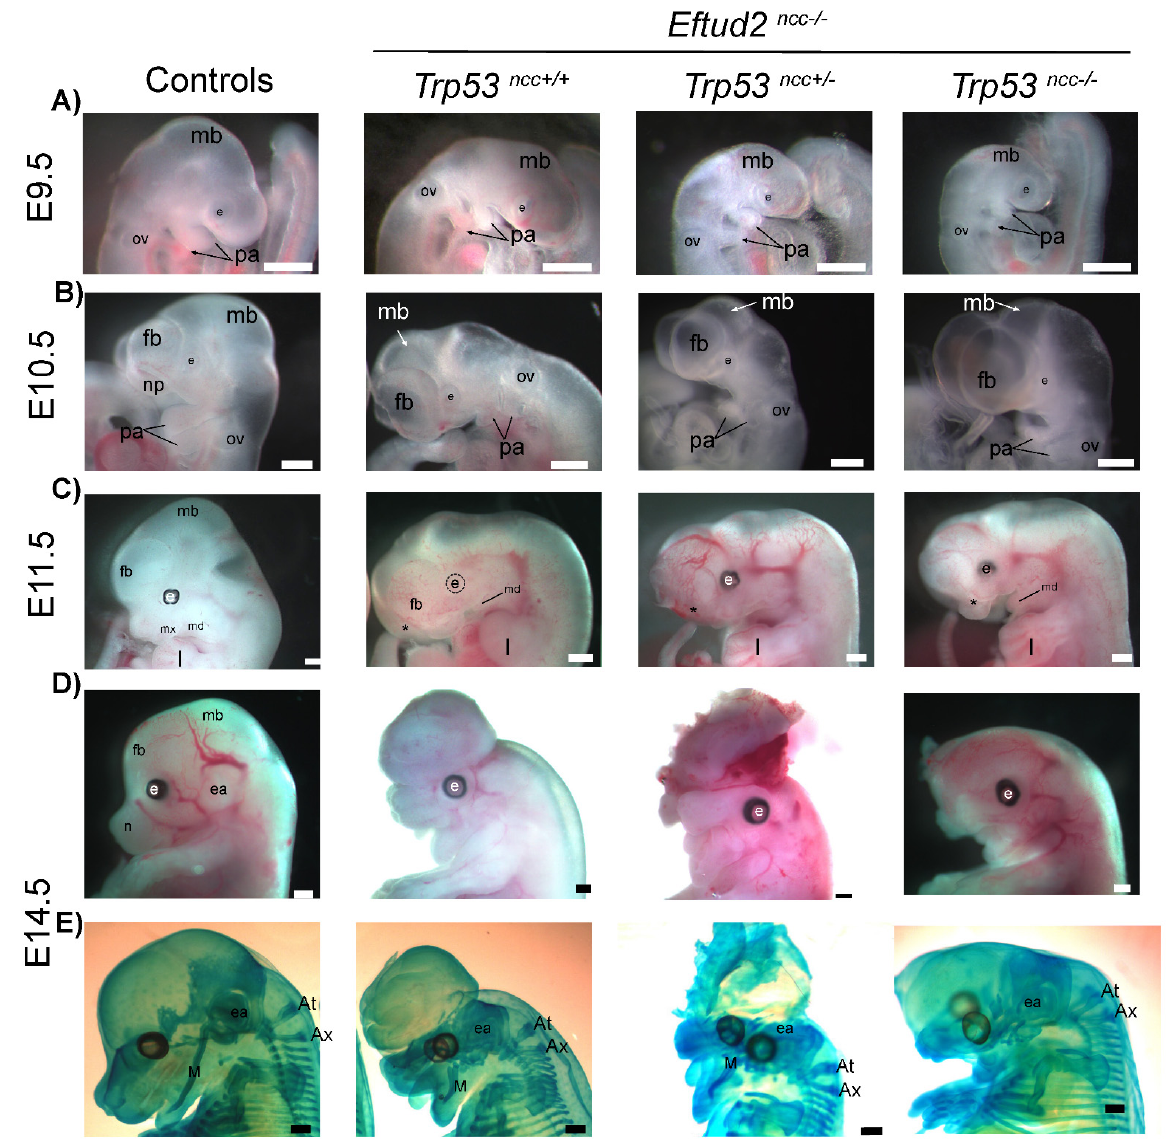
Figure 4. Removing Trp53 does not improve craniofacial development in Eftud2 ncc − / − mutants. Representative images of control, Eftud2 ncc − / − ; Trp53 ncc+/+ , Eftud2 ncc − / − ; Trp53 ncc+/ − and Eftud2 ncc − / − ; Trp53 ncc − / − embryos collected at ( A ) E9.5 and ( B ) E10.5 showing the reduced size of the midbrain and the pharyngeal arches. ( C ) The head of mutant embryos have an abnormal curvature; the mandible is reduced and the maxilla and the frontonasal process (stars) was missing in all E11.5 mutant embryos. ( D ) Representative images of E14.5 embryos ( E ) stained with Alcian blue for cartilage analysis showing a hypoplastic (Meckel’s cartilage) and absent cartilage structures in the head of mutants. Scale bar = 500 µ m. ov = otic vesicle, mb = midbrain, pa = pharyngeal arch, e = eye, fb = forebrain, np = nasal process, mx = maxillary, md = mandible, l = limb, ea = ear, n = nose, M = Meckel’s cartilage, At = atlas, Ax = axis. At E14.5, four of the sixteen Eftud2 ncc − / − ; Trp53 ncc+/ − embryos were alive, among which one was phenotypically normal ( n = 7 litters). Alcian blue staining revealed no cartilage defects in the phenotypically normal Eftud2 ncc − / − ; Trp53 ncc+/ − mutant (Figure S3C). In contrast, no phenotypically normal Eftud2 ncc − / − ; Trp53 ncc − / − embryo was recovered at this stage ( n = 3 litters). In fact, only one phenotypically abnormal Eftud2 ncc − / − ; Trp53 ncc − / − embryo was recovered alive at E14.5 ( n = 3 litters) (Figures 4D and